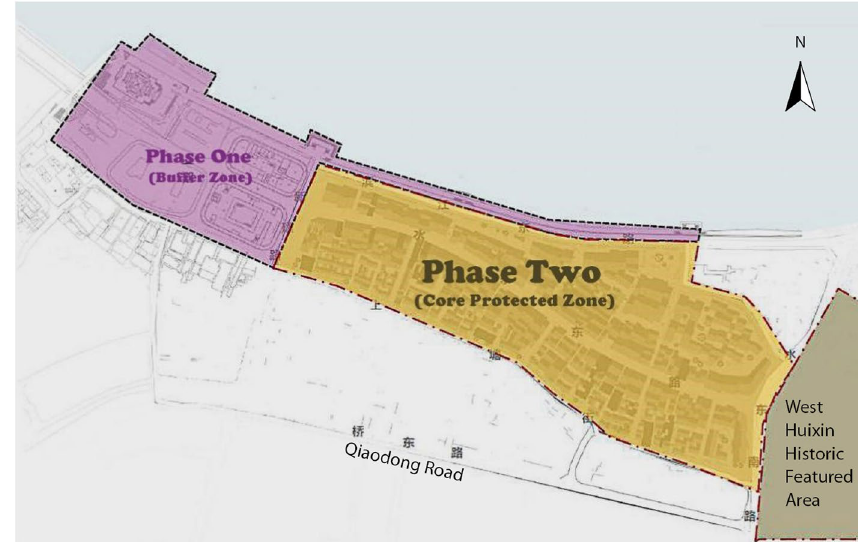
Fig. 7 Core protected and buffer zones in Shuidong Quarter. (Source: The People’s Government of Huizhou